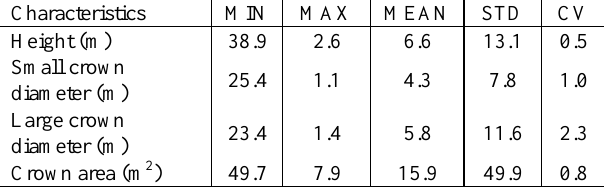
Table 2. Statistical summary of the biophysical characteristics of 324 P. eldarica trees measured on the RGB 2-cm resolution UAV